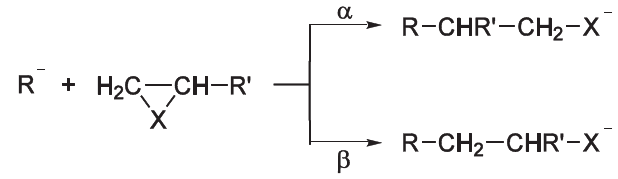
Figure 39. Nucleophilic ring-opening of asymmetrical